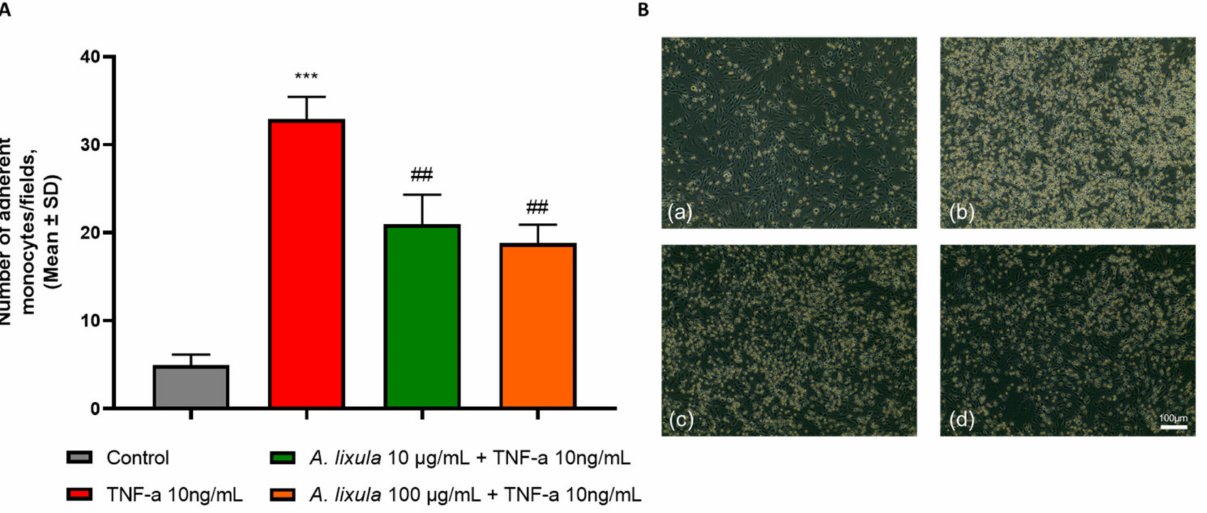
Figure 2. Effect of A. lixula extract on TNF- α -induced endothelial cell–monocyte adhesion. HMEC-1 were treated with A. lixula extract for 4 h at the concentration indicated, and then either treated with 10 ng/mL TNF- α or left untreated for 18 h. THP-1 were added to the HMEC-1 monolayers. Images of HMEC-1 and adherent THP-1 cells were visualized and counted ( A ). Data (means ± S.D., n = 3) are expressed as number of adherent monocytes per field. In ( B ), images captured with a phase contrast microscope (10 × magnification) are shown. ( a ) control; ( b ) TNF- α 10 ng/mL; ( c ) A. lixula extract 10 µ g/mL + TNF- α ; ( d ) A. lixula extract 100 µ g/mL + TNF- α . *** p < 0.001 vs. basal (untreated) control; ## p < 0.01 vs. TNF- α alone.